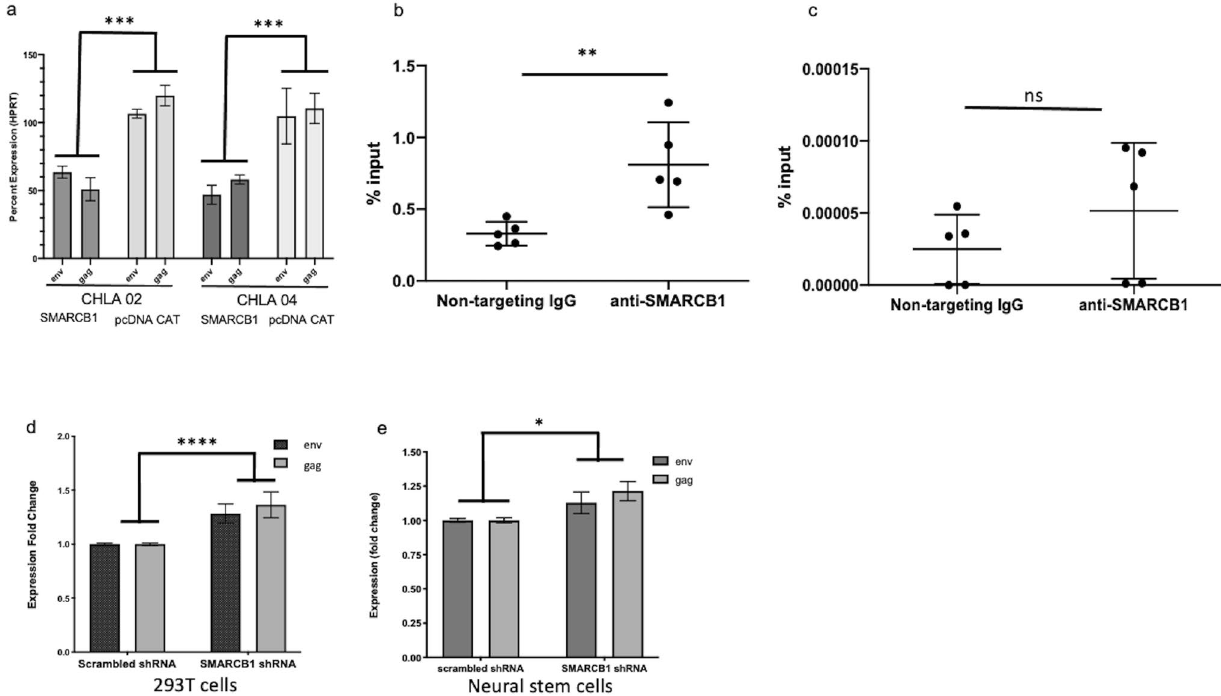
Figure 3. SMARCB1 regulates HERV-K (HML-2) env expression. ( a ) Restored SMARCB1 expression in CHLA 02 and CHLA 04 AT/RT cell lines results in downregulation of HML-2 transcription measured at 48 h by qRT- PCR. ( b , c ) SMARCB1 binds the HML-2 LTR significantly more than the promoter of control gene, HPRT . ( b ) SMARCB1 transfected 293 T cells show a significantly greater proportion of HML-2 LTR bound to SMARCB1 following immunoprecipitation compared to control, non-targeting IgG. ( c ) SMARCB1 transfected 293 T cells show no significant difference between non-targeting IgG bound to genomic HPRT and SMARCB1 bound to genomic HPRT . Percent input is a normalized value with input set to 100% (e.g. % input = 100*2^(input Ct − immunoprecipitated chromatin Ct). Ct is cycle threshold. ( d , e ) SMARCB1 knockdown results in increased transcription of HML-2 transcripts as measured with qRT-PCR. ( d ) HML-2 transcripts in 293 T cells transfected with scrambled shRNA control compared to shRNA targeting SMARCB1 at 24 h as measured by qRT-PCR. ( e ) HML-2 transcripts in neural stem cells transfected with scrambled shRNA control are significantly higher compared to transcripts in cells transfected with shRNA targeting SMARCB1 at 48 h. (qRT-PCR) Data was entered into Prism v9 for graph creation. [Error bars represent SEM. Statistics in Supplemental Table both of which play roles in transcriptional regulation (Supplemental Table S2). The genes in the second group were affiliated with the neuroblastoma breakpoint family ( NBPF ) (Supplemental Table S2); genes in this family, such as putative tumor suppressor NBPF1 , which is highly expressed in the brain, have repetitive structures containing both intragenic and intergenic sequences 39 . Proteomic analysis of these cell lines confirmed the high expression observed by RNA sequencing analysis and the immunohistochemistry (IHC). Two groups of highly expressed proteins were found after analysis with DAVID of the CHLA 02 and CHLA 04 AT/RT cells by liquid chromatography mass spectrometry (LCMS). Both cell lines expressed proteins associated with the cellular immune response to viral proteins, in addition to neural stem cell marker (nestin), neuronal marker (βIII-tubulin), and glial cells (vimentin), which clustered as the first group (Supplemental Table S3). One of the proteins highly expressed in CHLA 02 and CHLA 04 AT/ RT cells is adenovirus early region 1B associated protein 5, a protein known to be activated during adenoviral infection, which has been suggested as a marker for undifferentiated embryonic stem cells 40 . An enrichment of proteins related to cellular adhesion, such as genes affiliated with cadherin cell–cell binding, cell–cell junction, and cell–cell adhesion was detected in the second group (Supplemental Table S3). Identification of activated HML‑2 loci due to SMARCB1 loss. Initial RNA sequencing analysis from all four AT/RT cell lines revealed the expression of several loci from both LTR5_Hs and HML-2 int (Fig. 4a–c). However, while at least 36 loci expressed transcripts of HML-2 internal sequences, a minority of loci encoded potential proteins (Supplemental Table S4). HML-2 elements were actively expressed from all chromosomes except for 14, 15, 18, and 21 (Fig. 4a,b). The most actively transcribed HML-2 sequences were from chromo- somes 1 and 19 each of which had 13 LTR5_Hs transcripts and 3 HML-2 int (Fig. 4a). The expressed transcripts aligning to elements encoding at least one full-length HML-2 gene are listed in Supplemental Table S4. Of these, only the locus on Chr19q11 encodes full length and potentially functional env protein (highlighted in Sup- plemental Table S4). Using a second analysis method, the TEtranscripts pipeline 41,42 (Supplemental Fig. S3), transcripts were detected from all chromosomes except 21 (Supplemental Fig. S3a). Three loci identified by